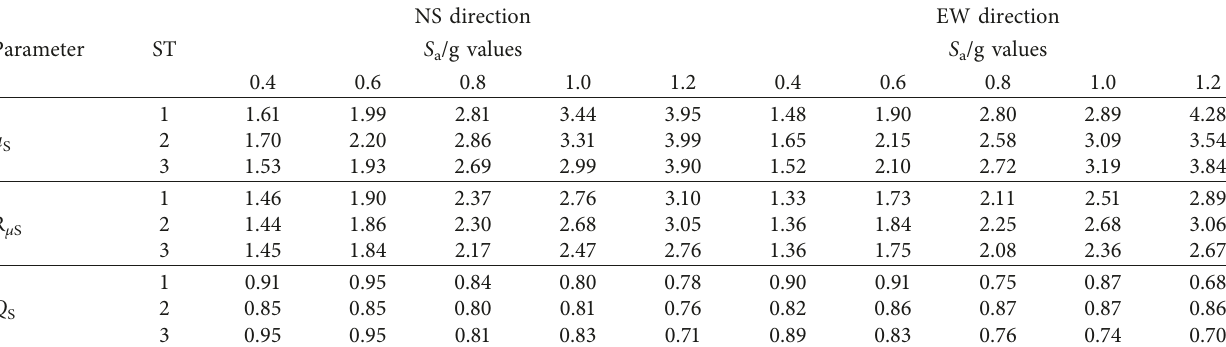
Figure 3: 10-level building. Mean values of µ L ϕ : (a) beams NS; (b) beams EW; (c) columns NS; (d) columns EW. Mean values of R µ L ϕ : (e) beams NS; (f) beams EW; (g) columns NS; (h) columns EW. Table 4: Statistics for µ S , R µ S , and Q S , 3-level